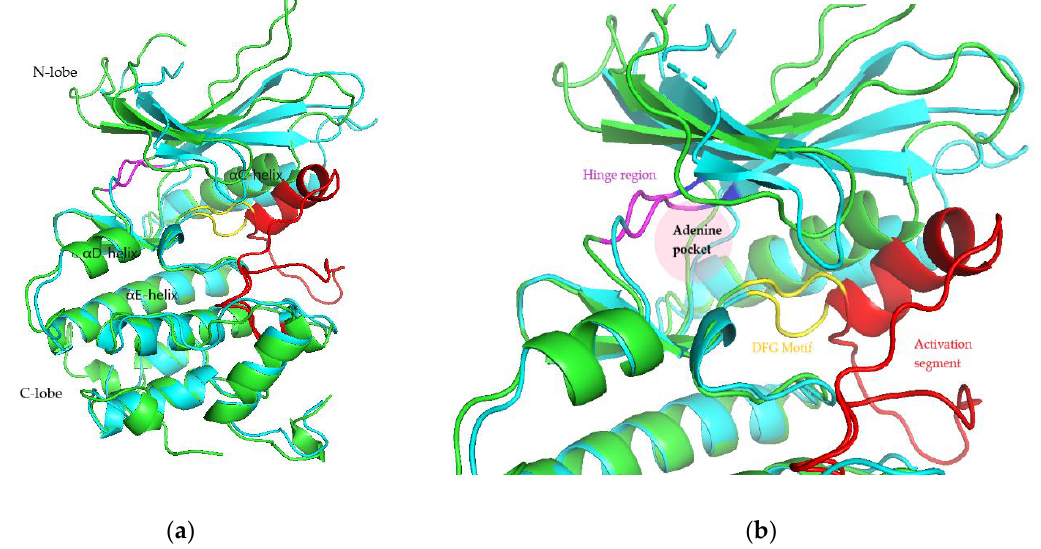
Figure 5. 3D structure ( a ) and ATP binding site ( b ) of CDK4 (green) and CDK6 (cyan).